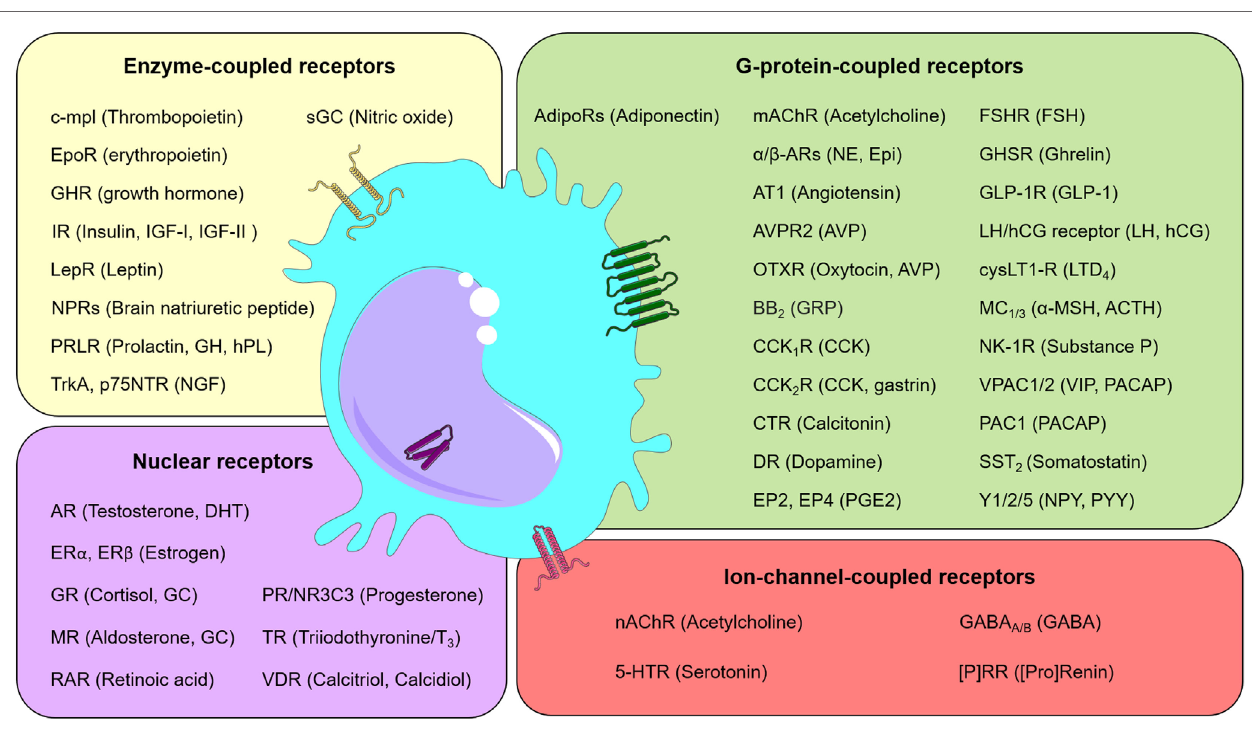
FiGURe 1 | Neuroendocrine communication on macrophages. Schematic representation listing selected receptors (and their ligands) found in macrophages. Receptors were grouped into classes, as indicated. Abbreviations: (P)RR, (pro)renin receptor; 5-HTR, serotonin receptor; ACTH, adrenocorticotropic hormone; AdipoRs, adiponectin receptors; AR, androgen receptor; AT1, angiotensin II receptor type 1; AVP, arginine vasopressin or antidiuretic hormone; AVPR2, arginine vasopressin receptor 2; BB2, bombesin receptor; CCK, cholecystokinin; CCK 1/2 R, cholecystokinin receptor 1/2, respectively; c-mpl, myeloproliferative leukemia protein; CO, carbon monoxide; CTR, calcitonin receptor; cysLT1-R, cysteinyl leukotriene receptor 1; DHT, dihydrotestosterone; DR, dopamine receptor; EP2, prostaglandin E2 receptor 2; EP4, prostaglandin E2 receptor 4; Epi, epinephrine; EpoR, erythropoietin receptor; ER, estrogen receptor; FSH, follicle-stimulating hormone; FSHR, follicle-stimulating hormone receptor; GABA, gamma-aminobutyric acid; GABA A/B , GABA A -receptor and GABA B -receptor, respectively; GC, glucocorticoids; GH, growth hormone; GHR, growth hormone receptor; GHSR, growth hormone secretagogue receptor (also known as ghrelin receptor); GLP-1, glucagon-like peptide-1; GLP-1R, Glucagon-like peptide-1 receptor; GR, glucocorticoid receptor; GRP, gastrin-releasing peptide; hCG, human chorionic gonadotropin; hPL, human placental lactogen; IGF, insulin-like growth factor; IR, insulin receptor; LepR, leptin receptor; LH, luteinizing hormone; LTD 4 , leukotriene D 4 ; mAChR, muscarinic acetylcholine receptor; MC 1/3 , melanocortin 1/3 receptor, respectively; MR, mineralocorticoid receptor; nAChR, nicotinic acetylcholine receptor; NE, norepinephrine; NGF, nerve growth factor; NK-1R, neurokinin 1 receptor; NPRs, natriuretic peptide receptors; NPY, neuropeptide Y; NR3C3, nuclear receptor subfamily 3, group C, member 3; OTXR, oxytocin receptor; p75NTR, neurotrophin receptor p75; PAC1, pituitary adenylate cyclase- activating polypeptide type I receptor; PACAP, pituitary adenylate cyclase-activating peptide; PGE2, prostaglandin 2; PR, progesterone receptor; PRLR, prolactin receptor; PYY, Peptide YY; RAR, retinoic acid receptor; sGC, soluble guanylyl cyclase; Soluble guanylyl cyclase (GC-1); SST 2 , somatostatin receptor type 2; TR, thyroid hormone receptor; TrkA, transmembrane tyrosine kinase; VDR, vitamin D receptor; VIP, vasoactive intestinal peptide; VPAC1/2, vasoactive intestinal peptide receptor 1/2, respectively; Y1/2/5, neuropeptide Y receptor type 1/2/5, respectively; α / β -ARs, α / β -adrenergic receptors; α -MSH, melanocyte-stimulating